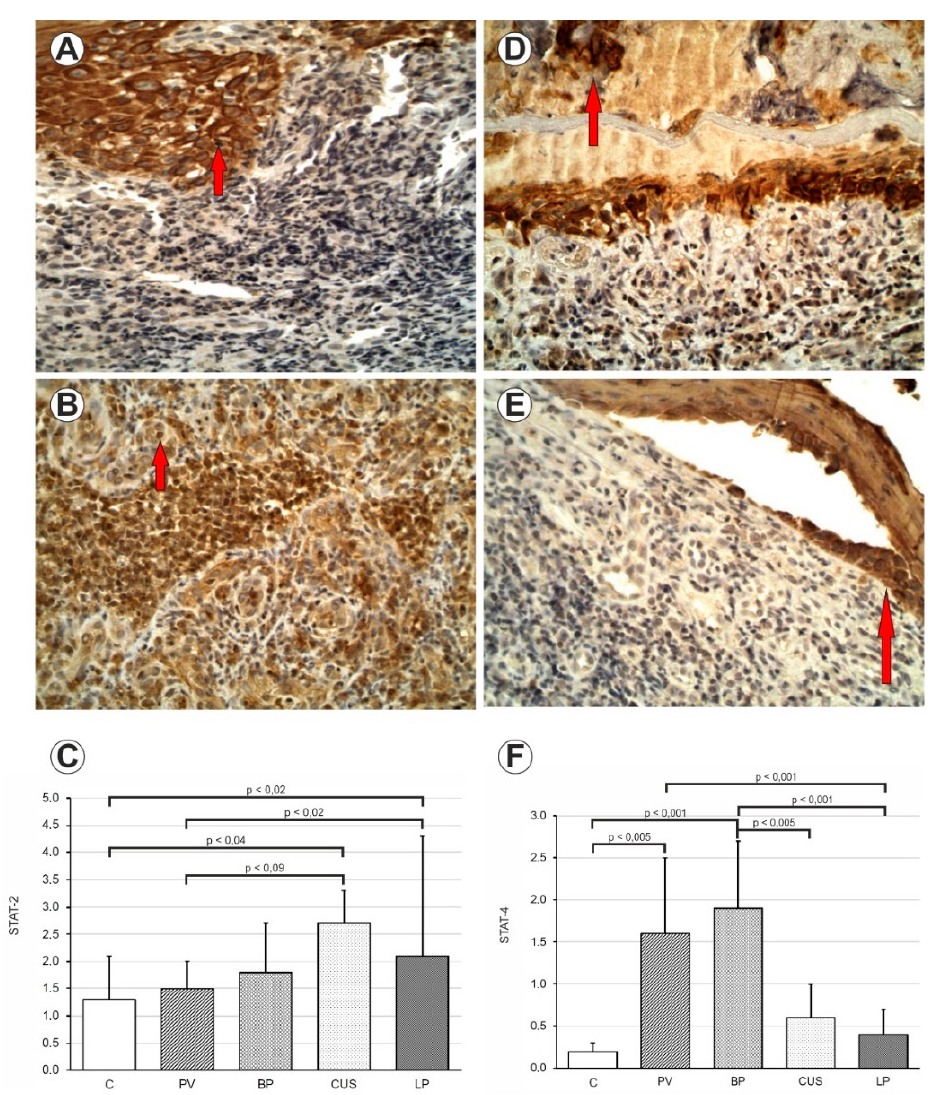
Figure 1. ( A ) Immunohistochemistry. STAT2 expression in epithelial cells and inflammatory influx. CUS. 400 × mag. ( B ) Immunohistochemistry. STAT2 expression in epithelial cells and